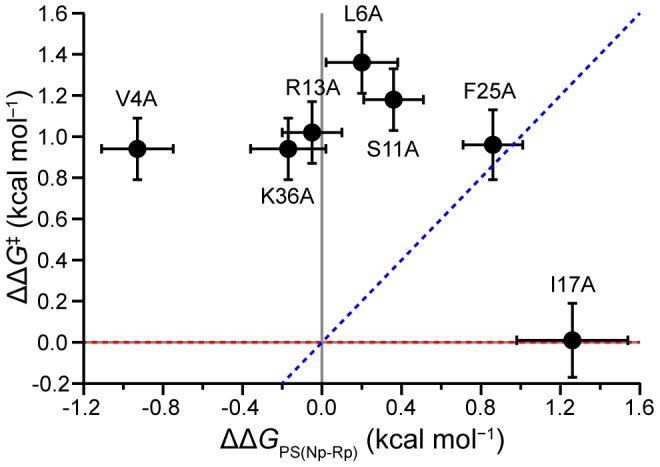
Brønsted plot.A comparison of the mutation effects on the folding activation energy as a function of the change in equilibrium stability. Dashed lines indicate the trend lines for ΔΔG values that would give rise to Φ-values of 0 or 1 and error bars show ± SD.